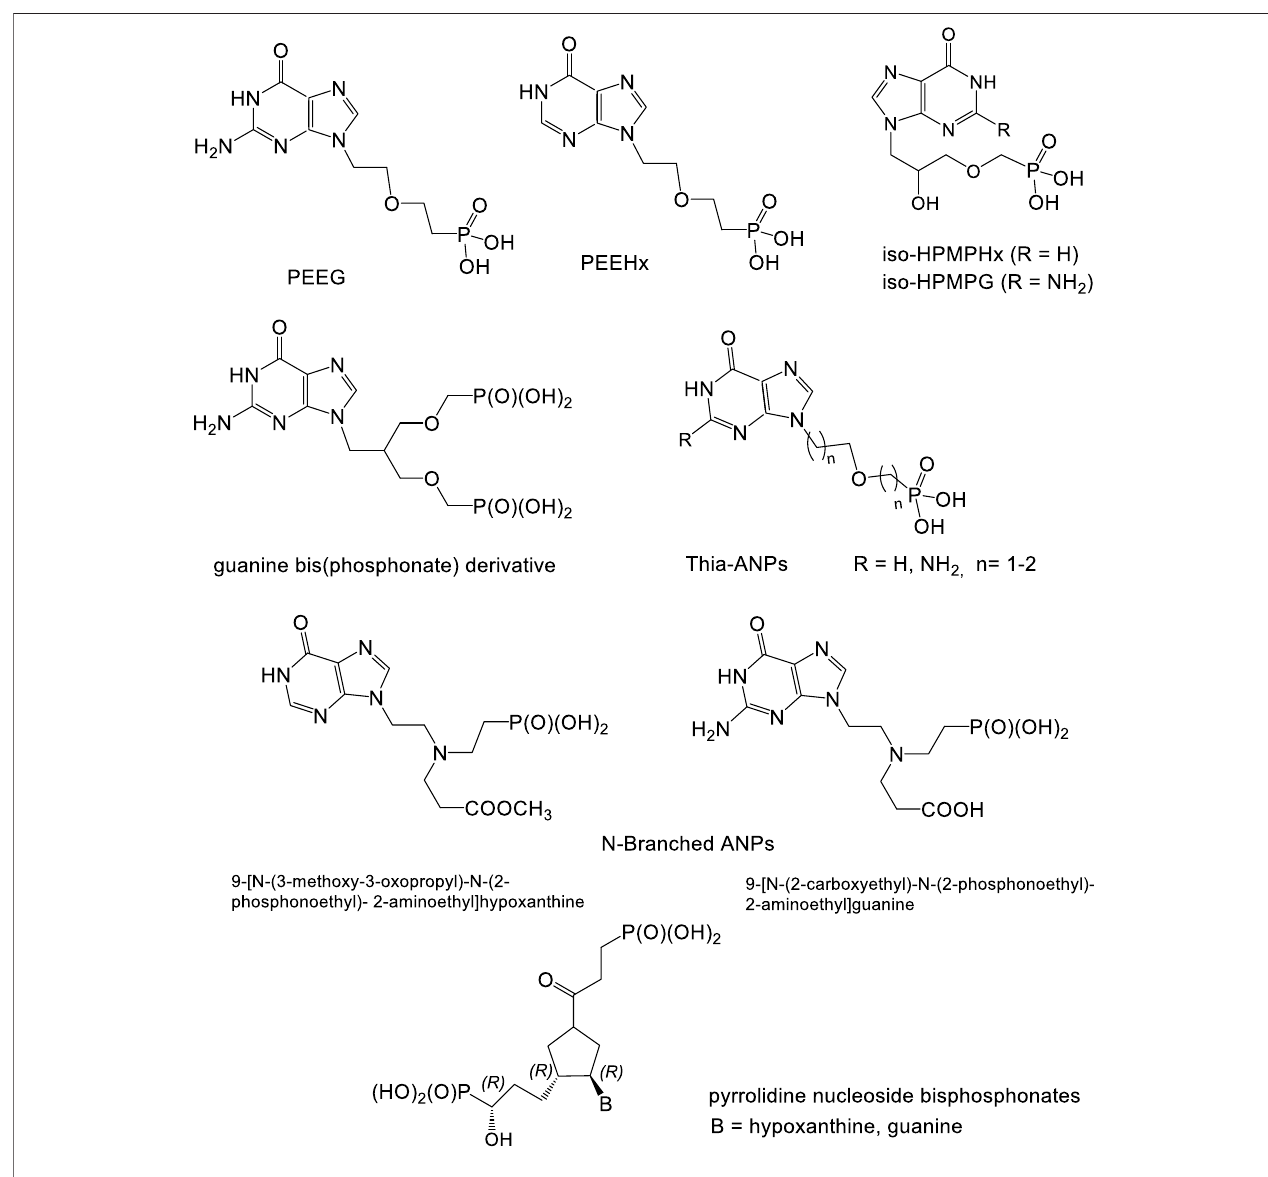
FIGURE 14 | Acyclic nucleoside phosphonates as potential antimalarial agents.